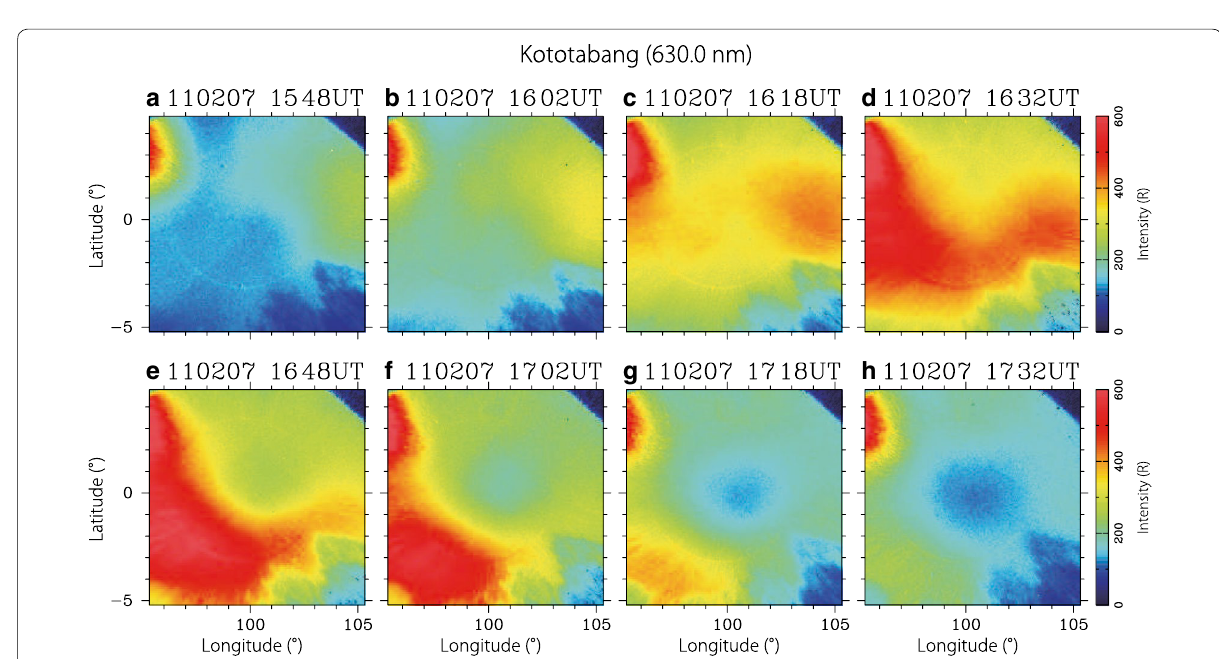
Fig. 3 Two-dimensional 630-nm airglow images from 1548 to 1732 UT on February 7, 2011, at Kototabang represented as absolute airglow inten- sity (R). These images are converted from all-sky coordinates to geographic